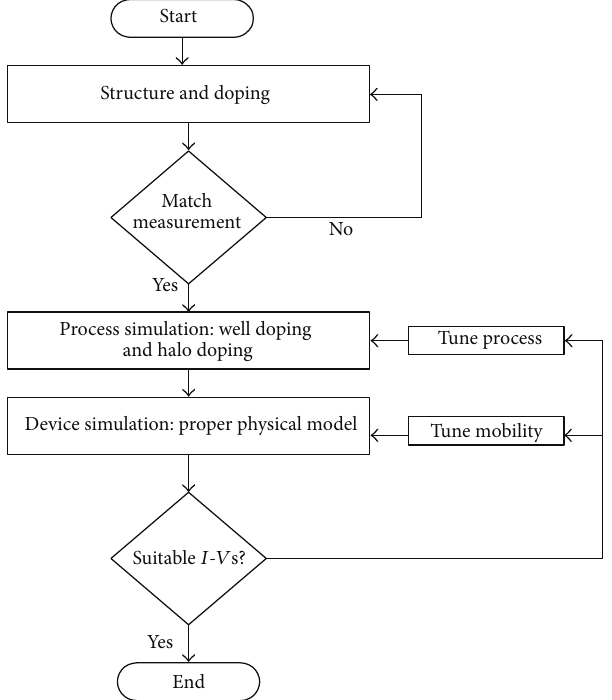
Figure 3: Flowchart for calibration methodology used in simulation [8].